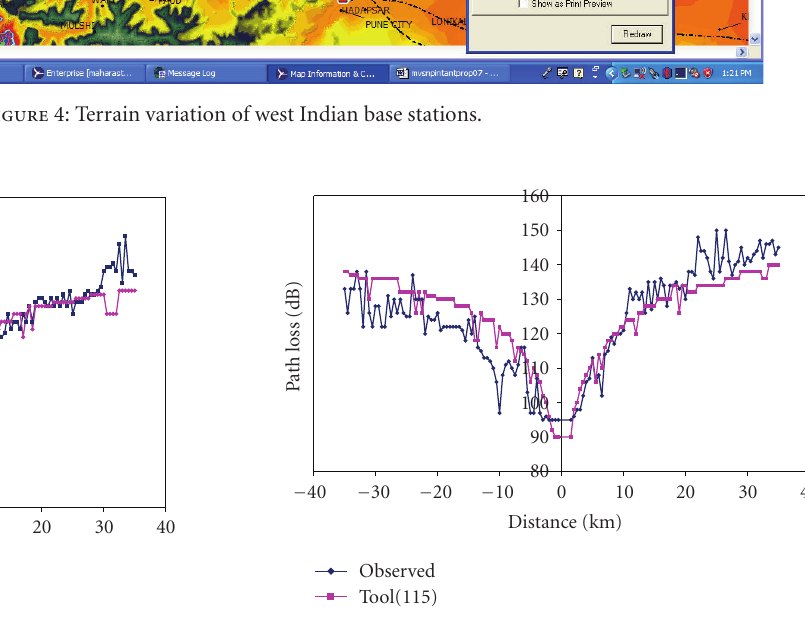
Figure 5: Comparison of tool predicted losses with observed losses versus track distance for Meerut base station.